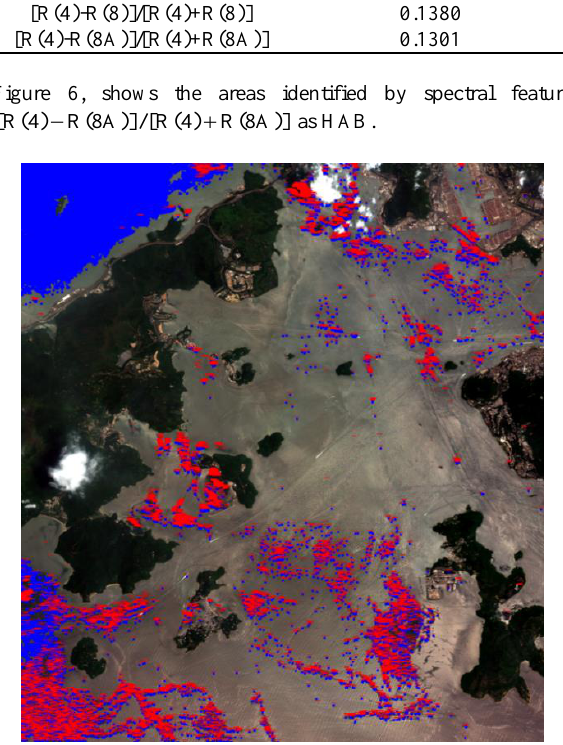
Figure 6. Red areas represent HAB